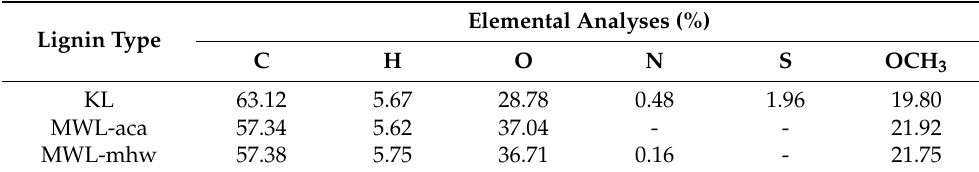
Table 2. Elemental analyses and methoxyl contents of KL and MWLs. Lignin